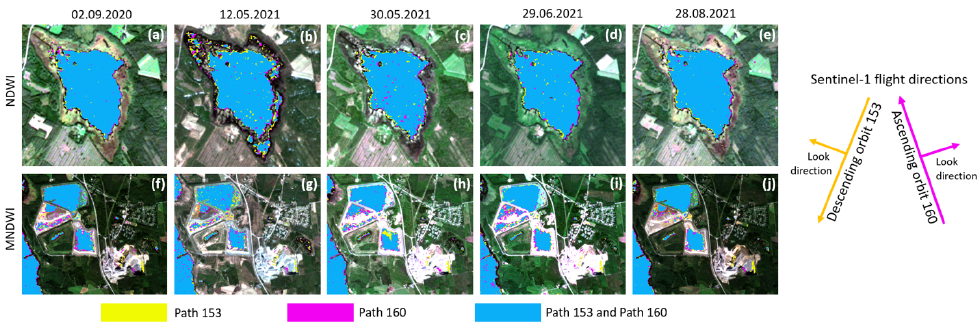
Figure 18. Different-time SAR mask maps of surface water bodies based on σ 0 two orbits for Lake Lohvanjärvi ( a – e ) and the Pyhäsalmi mine area ( f – j ): ( a , f ) 02 September 2020; ( b , g ) 12 May 2021; ( c , h ) 30 May 2021; ( d , i ) 29 June 2021; ( e , j ) 28 August 2021. Basemap: Sentinel-2 RGB (band-4, band-3, band-2).